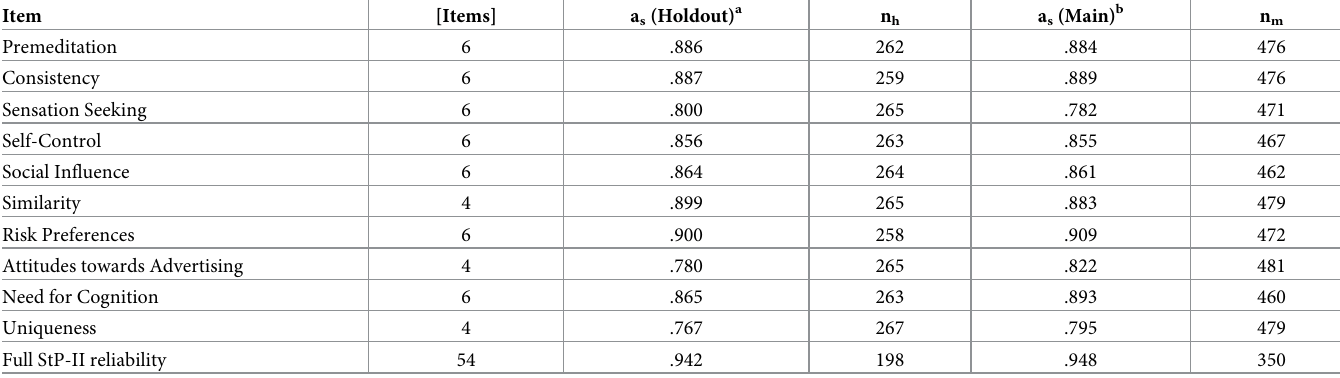
Table 1. Reliability scores for susceptibility to persuasion scale—II on holdout (n = 278) and main (n = 500) samples.